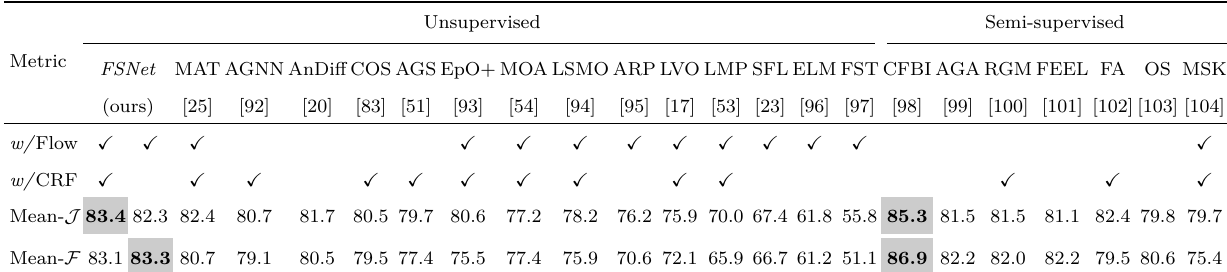
Table 1 Video object segmentation (VOS) results of our FSNet , compared to 14 state-of-the-art unsupervised models and 7 semi-supervised models on the DAVIS 16 [35] validation set. w/ Flow: the optical flow algorithm was used. w/ CRF: a conditional random field [84] was used for post-processing. Best scores are marked in bold Unsupervised Semi-supervised